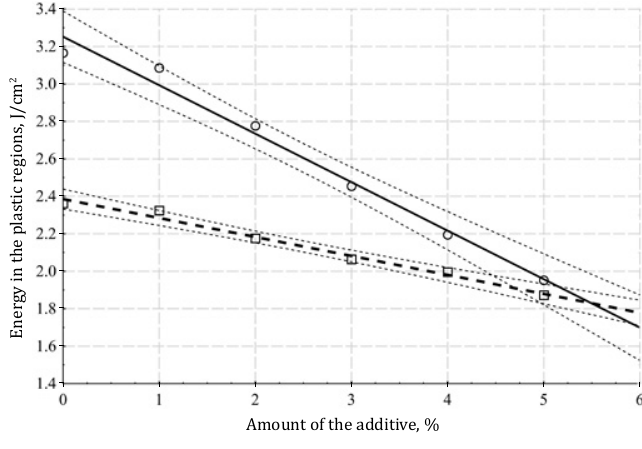
Figure 7. Ring and Ball softening point